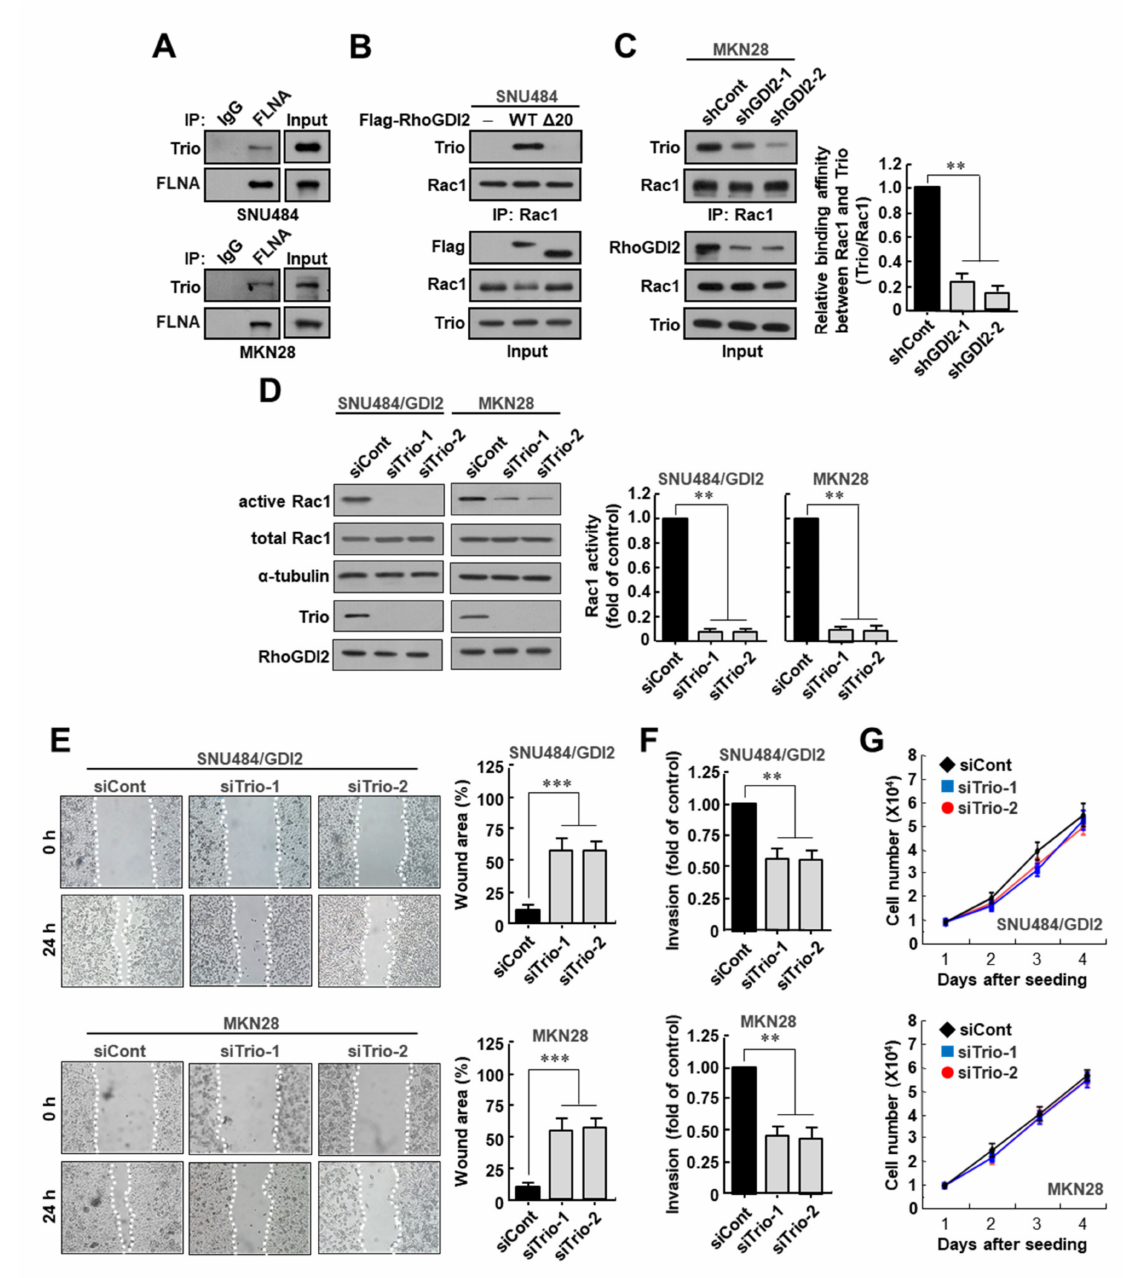
Figure 4. Trio is critical for Rac1 activation and invasive ability of gastric cancer cells. ( A ) Interaction between endogenous Filamin A with endogenous Trio in SNU484 and MKN28 cells. SNU484 and MKN28 cells were immunoprecipitated and analyzed by Western blot. The uncropped immunoblot images can be found in Figure S6. ( B ) Interaction between endogenous Rac1 with endogenous Trio in the presence of wild type RhoGDI2 or RhoGDI2 ∆ 20 in SNU484 gastric cancer cells. SNU484 cells transfected with indicated constructs were immunoprecipitated and analyzed by Western blot. The uncropped immunoblot images can be found in Figure S6. ( C ) Interaction between endogenous Rac1 with endogenous Trio in RhoGDI2-depleted MKN28 gastric cancer cells. MKN28 cells transfected with indicated constructs were immunoprecipitated and analyzed by Western blot ( left ). The data are representative of three independent experiments, and relative Rac1 and Trio levels were